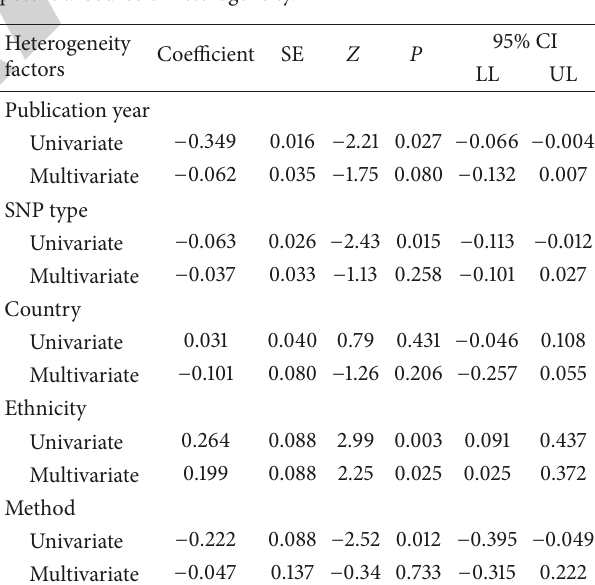
Table 3: Univariate and multivariate metaregression analyses of potential source of heterogeneity.